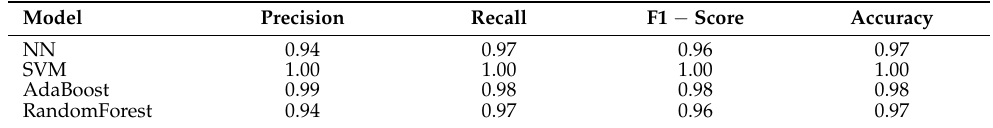
Table 7. Results of classification